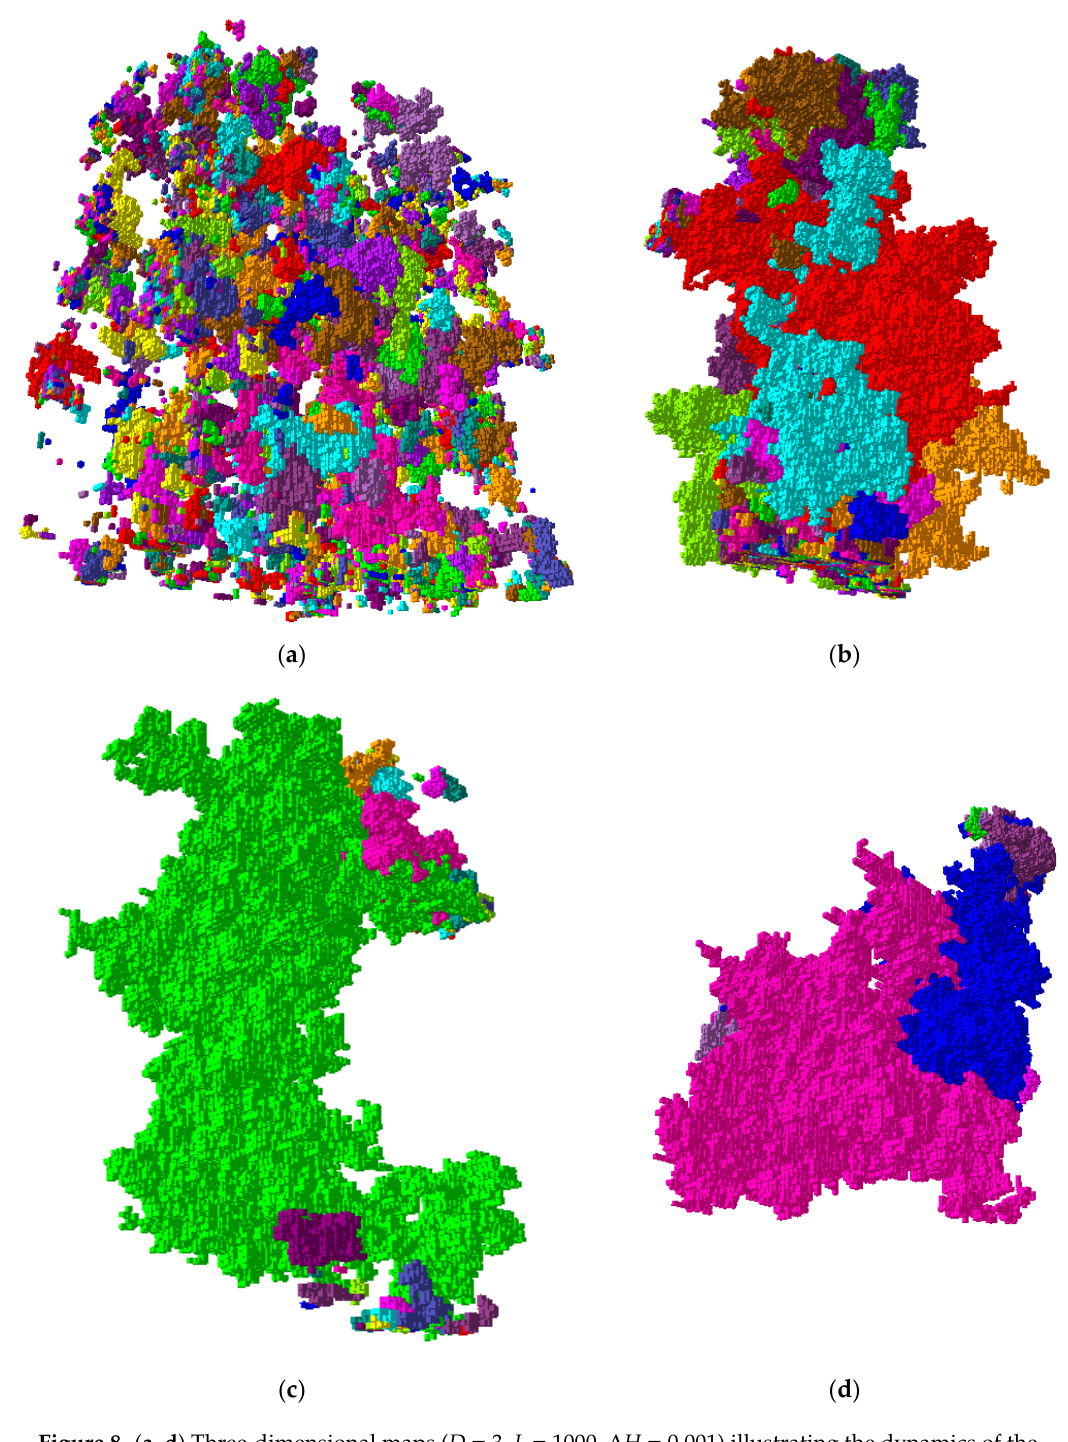
Figure 8. ( a – d ) Three-dimensional maps ( D = 3, L = 1000, ∆ H = 0.001) illustrating the dynamics of the magnetization process for various disorders R = {2.5, 2.0, 1.5, 1.0} respectively. Single-colored areas represent spins that were flipped due to avalanche interactions in metastable conditions.